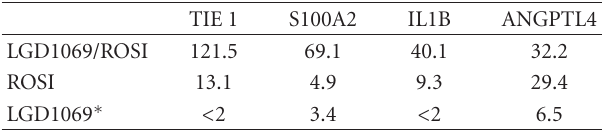
Table 5: Four genes with the highest mRNA stimulation after combination TZD/rexinoid